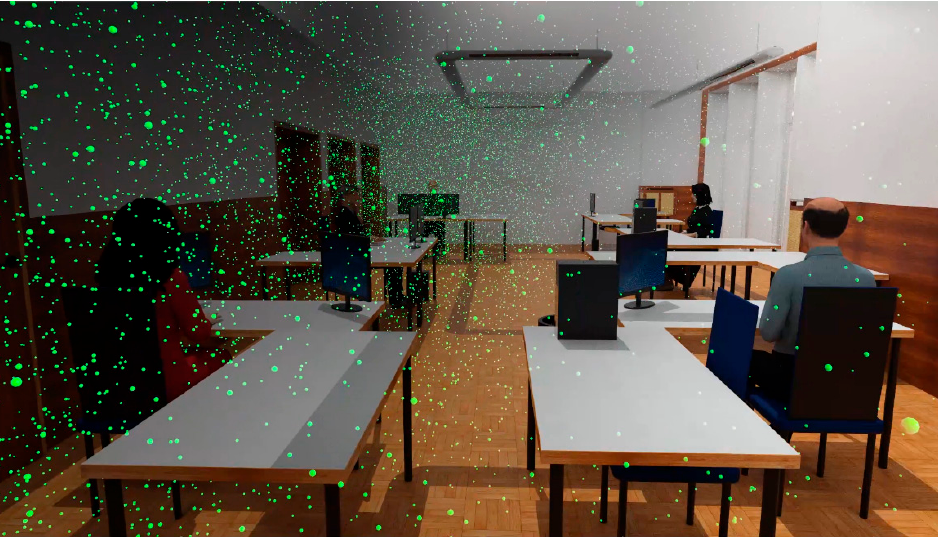
Figure 7. Particles at a certain point in time simulated inside room.